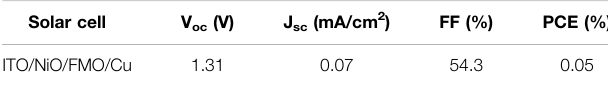
TABLE 1 | Extracted solar cell parameters from the J – V characterization of the ITO/NiO/FeMnO 3 /Cu device.